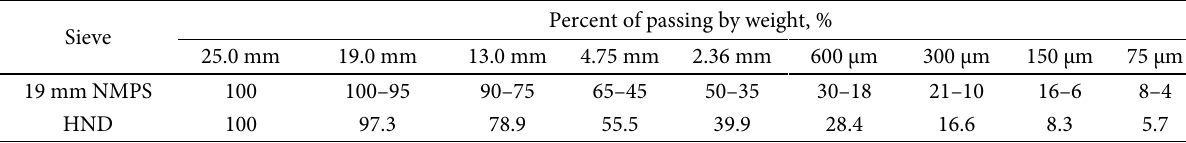
Table 3. The Bailey ratios of the HND mixture Bailey items % CALUW PCS CA FA c FA f Recommended